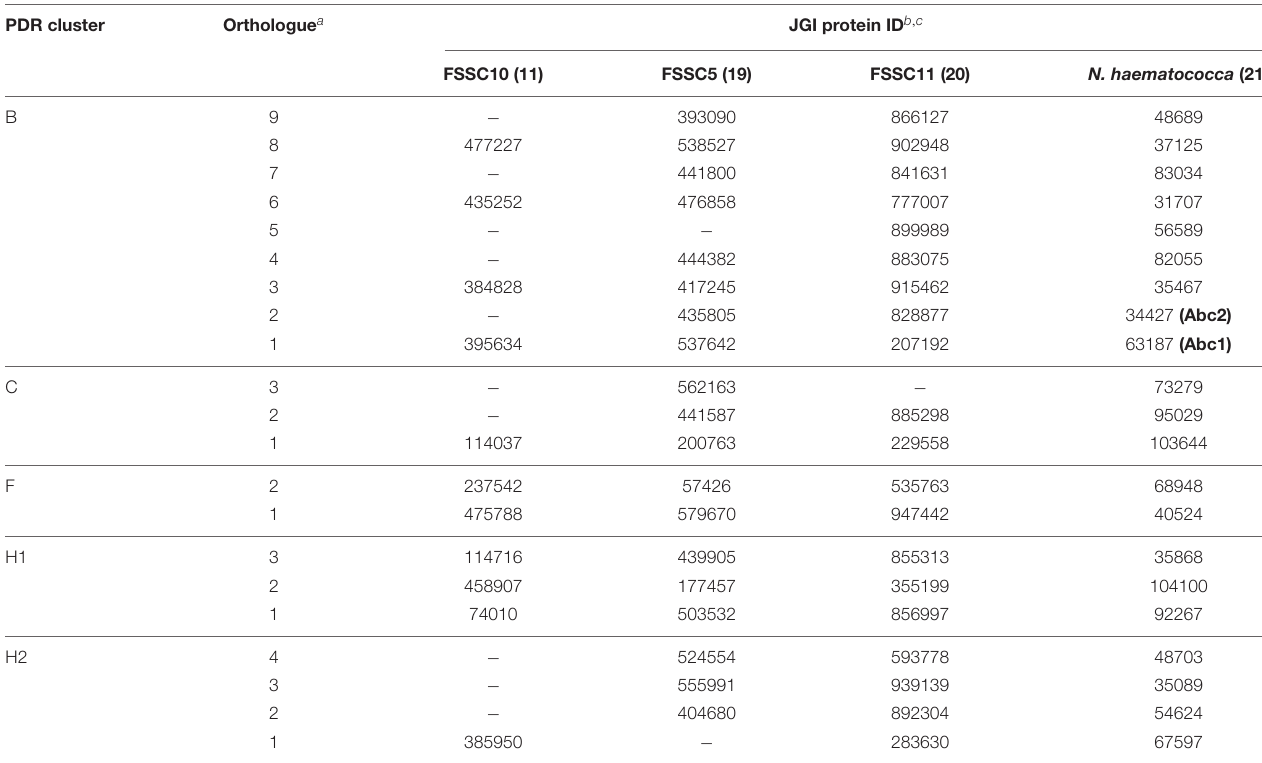
TABLE 4 | List of full-size PDR transporters of four FSSC species. PDR